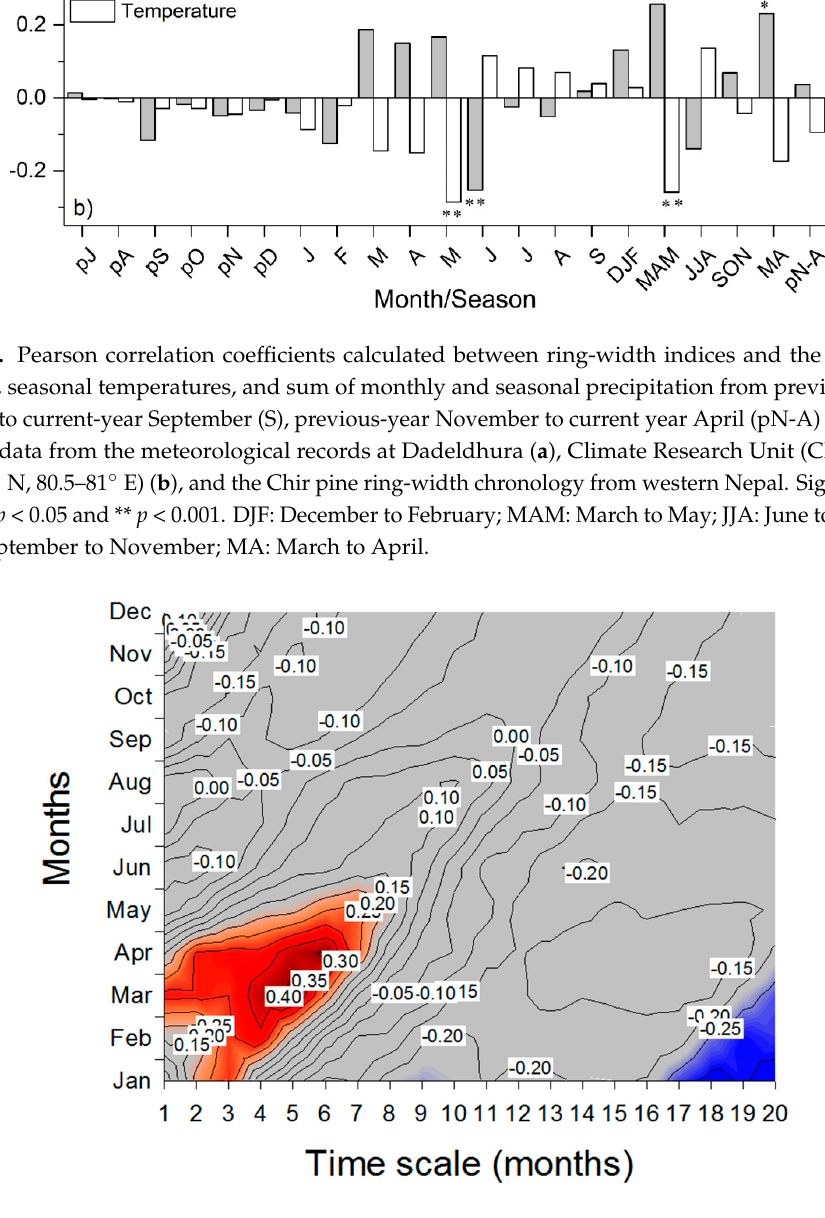
Figure 7. Fields of highest Pearson correlation coefficients calculated between monthly values of the Standardized Precipitation Evapotranspiration Index (SPEI) (1972–2010) and the Chir pine ring-width chronology. Correlations above 0.25 and below − 0.25 (shown as color-filled contours) are significant at the 0.05 level. SPEI values were calculated for 1- to 20-month-long intervals (X axis).